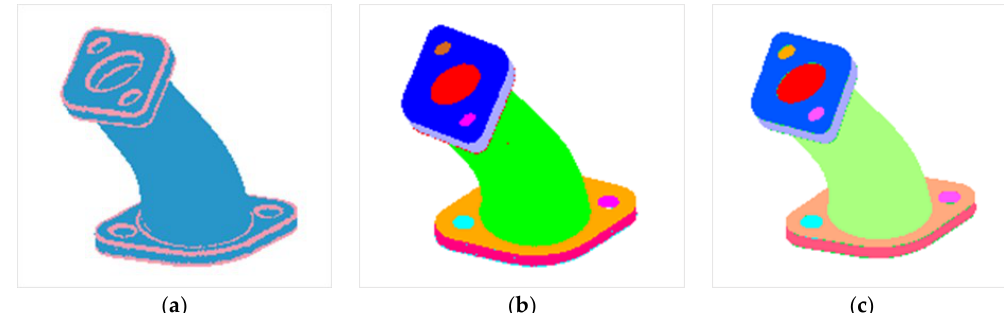
Figure 13. Experimental results of the connecting piece model: ( a ) feature point segmentation; ( b ) feature surface extraction; ( c ) feature surface reconstruction.